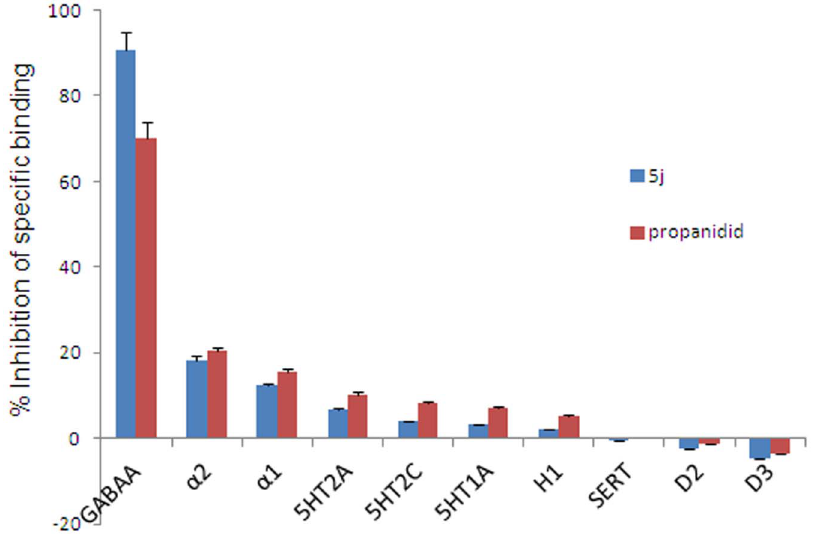
Figure 6. Specific radioligand binding to off-target receptors by compound 5j (50 m mol). Data were expressed as the means 6 SD.